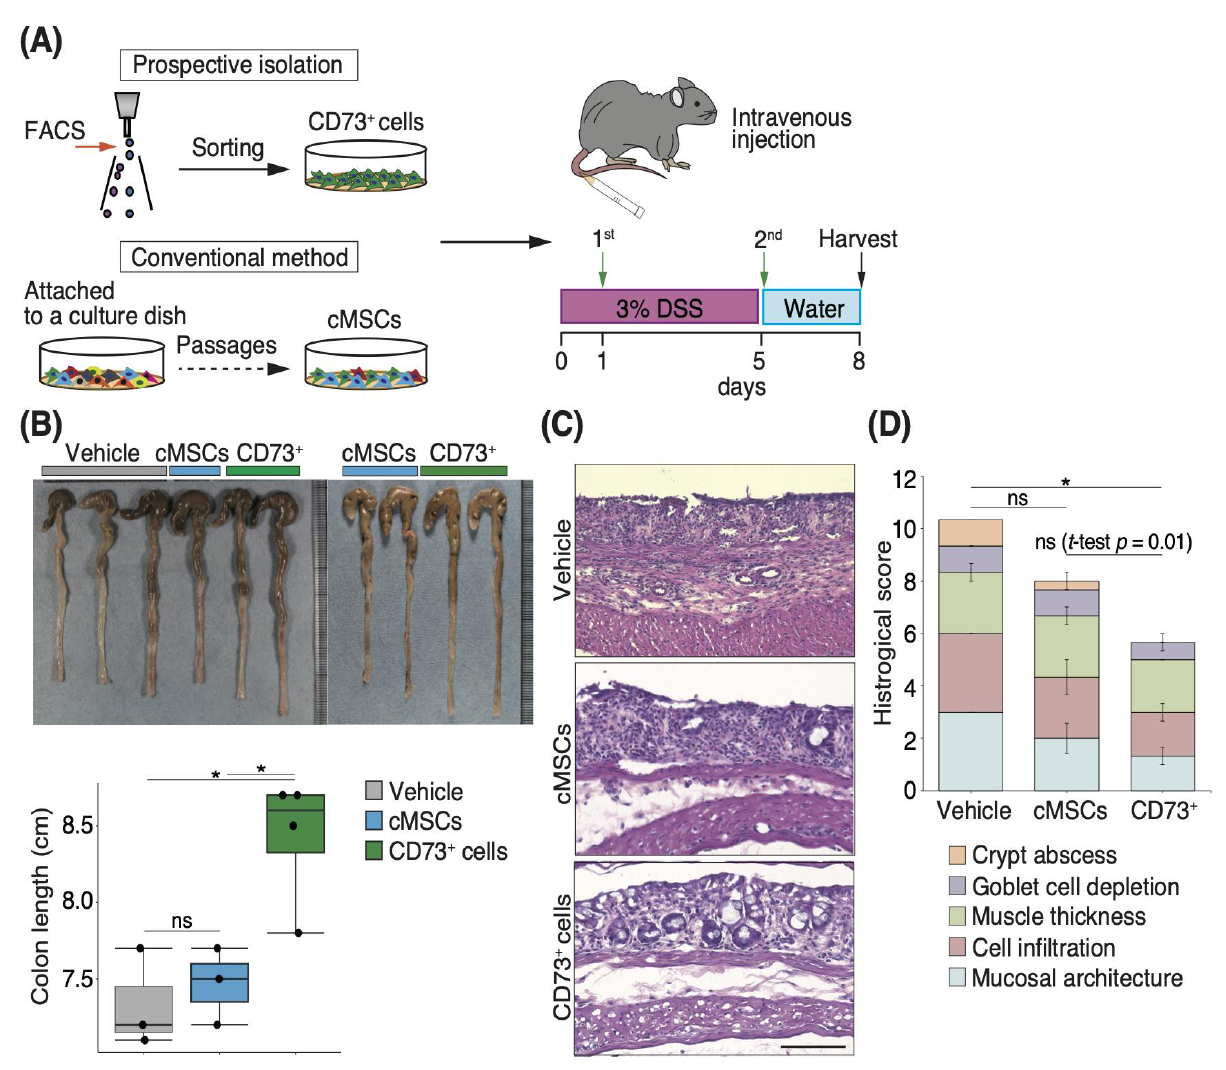
Figure 1. Intravenous injection of CD73 + cells attenuates the destruction of intestinal structure in dextran sulfate sodium salt (DSS)-induced colitis. ( A ) Schematic diagram showing the isolation method and transplantation schedule of CD73 + cells and conventional heterogeneous mesenchymal stem cells (cMSCs). ( B ) Representative images of the colon after DSS-induced colitis. Lower graph shows the colon length 8 days after DSS administration. Vehicle, phosphate-buffered saline (PBS)- treated group; cMSCs, cMSC-transplanted group; CD73 + , CD73 + cell-transplanted group. n = 10 mice from 2 independent experiments. Two mice in the PBS-treated group and one mouse in the cMSC-transplanted group died before analysis. ( C ) Representative images of hematoxylin and eosin (H&E) staining of the injured colonic tissue. Scale bar: 100 µ m. ( D ) Graph showing histological score based on H&E staining of the colonic tissue. The colors represent the following criteria: mucosal architecture (0–3), immune cell infiltration (0–3), muscle layer thickness (0–3), depletion of goblet cells (0–1), and crypt abscess (0–1). Statistical significance was determined using the Tukey’s test and Welch’s t -test. Data are shown as mean ± standard error of mean (SEM). * p < 0.05; ns, not